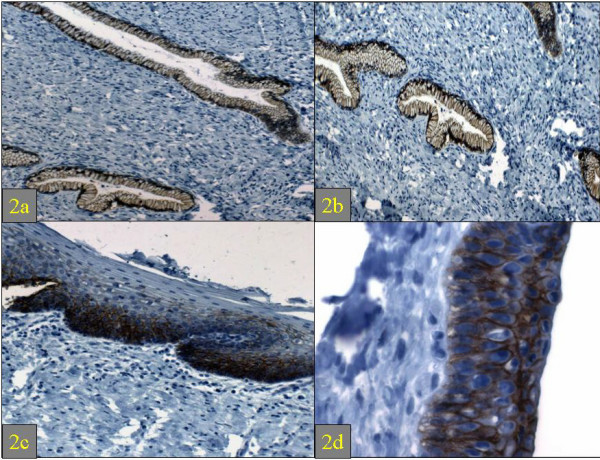
Expression of E-Cadherin in the normal endocervix (2a, hematoxylin and eosin, original magnification ×100; 2b: hematoxylin and eosin, original magnification ×200), ectocervix (2c: hematoxylin and eosin, original magnification ×100) and squamous metaplastic epithelium at the transformation zone (2d) (hematoxylin and eosin, original magnification ×200).